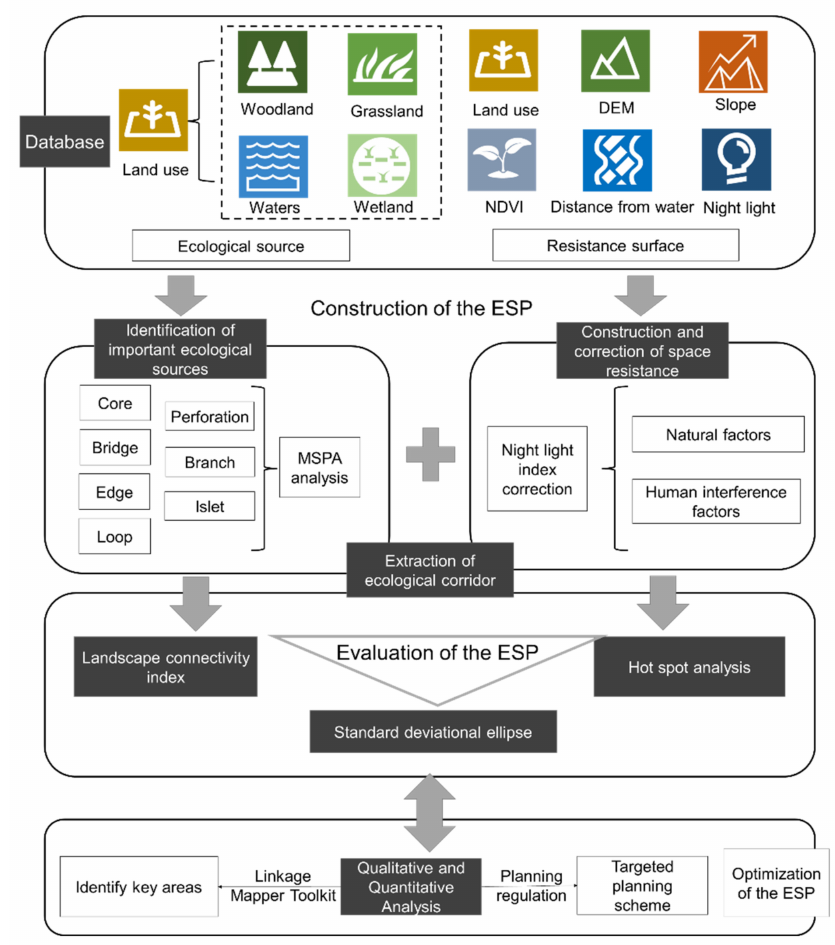
Figure 2. Research